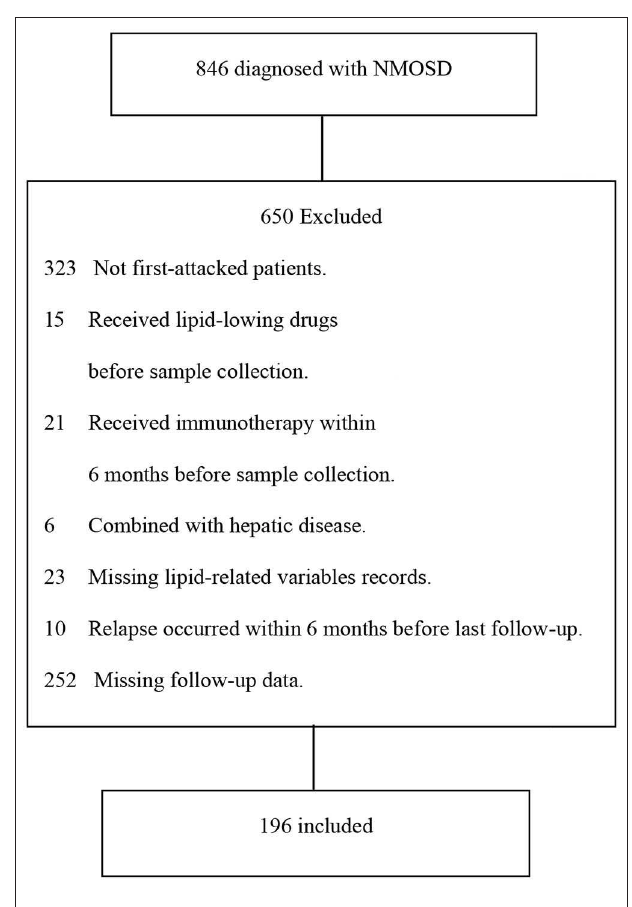
FIGURE 1 | Patients screening process. From June 2014 to December 2018, 846 consecutive cases with NMOSD were admitted to our department. Six hundred and fifty patients did not meet the inclusion criteria, and we finally included 196